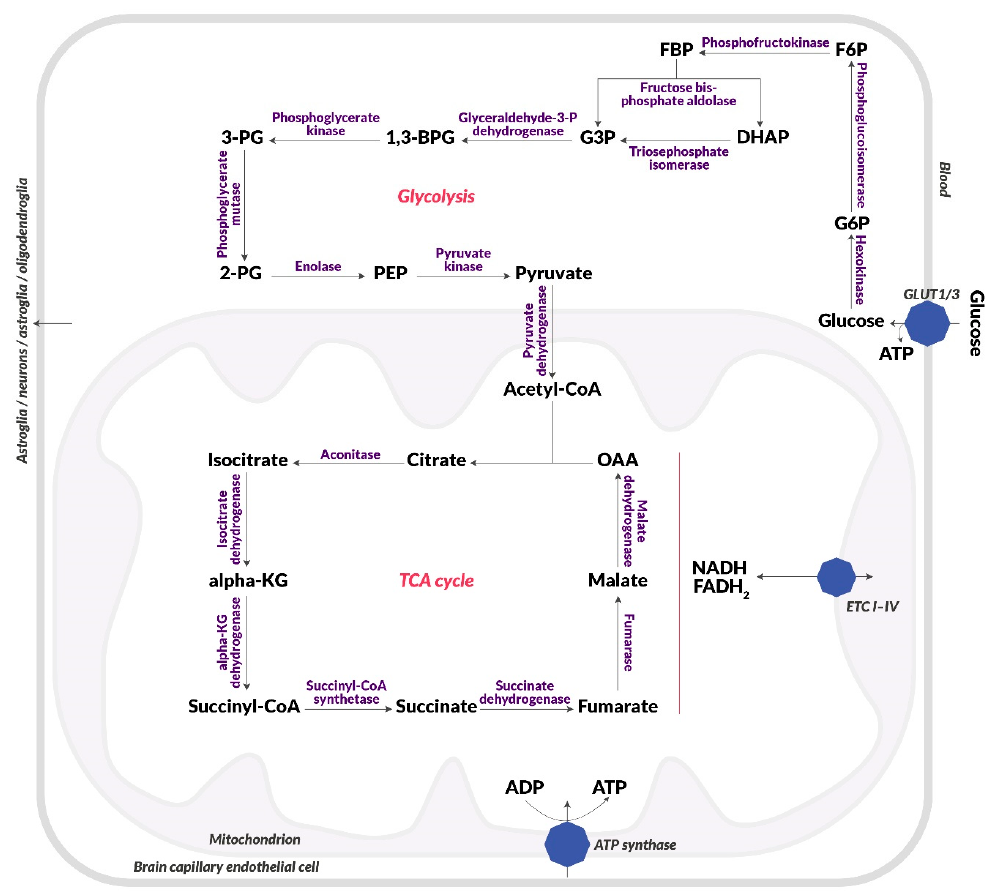
Figure 1. Diagram of glucose metabolism. Blood glucose uptake, glycolysis, citric acid cycle, electron Table 1, and an insulin-independent transporter (GLUT3). Then, it is metabolized in cytosol in glycolysis to pyruvic acid, which passes into the mitochondria. Pyruvate dehydrogenase converts it to acetyl-CoA, which is included in the citric acid cycle (TCA), which runs in the mitochondrial matrix. There, NADH and FADH2 are produced, which end up in the electron transport chain (I-IV) (ETC I-IV), which is located on the inner membrane of the mitochondrion. NADH and FADH2 are used to create a proton gradient, which is then used to produce ATP by ATP synthase. Abbreviations: 1,3-BPG: